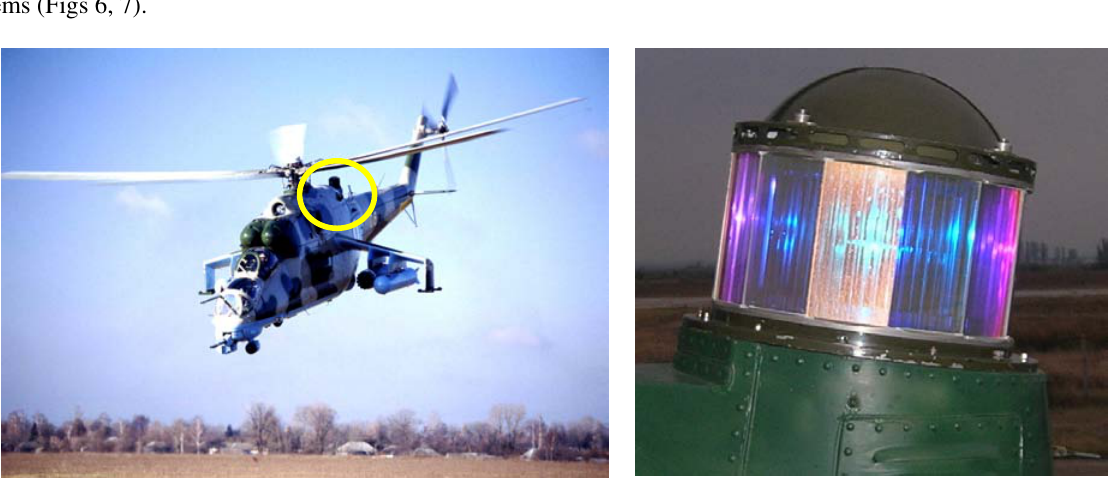
Fig 6. Active protection system on the Mi-24 helicopter Fig 7. Adron opto-electronic suppression